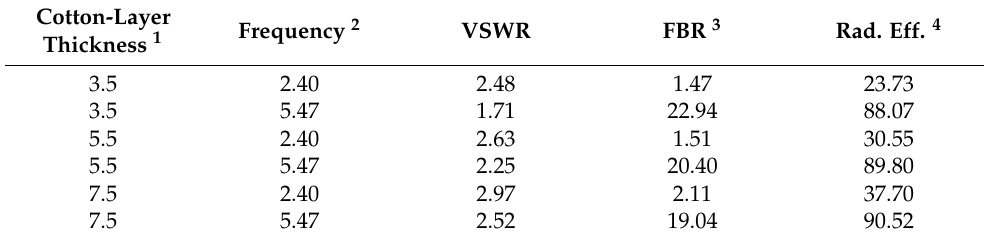
Table 2. Antenna parameters at different cotton-layer thicknesses. The dimensions of the other antenna elements are those shown in Figure 1.